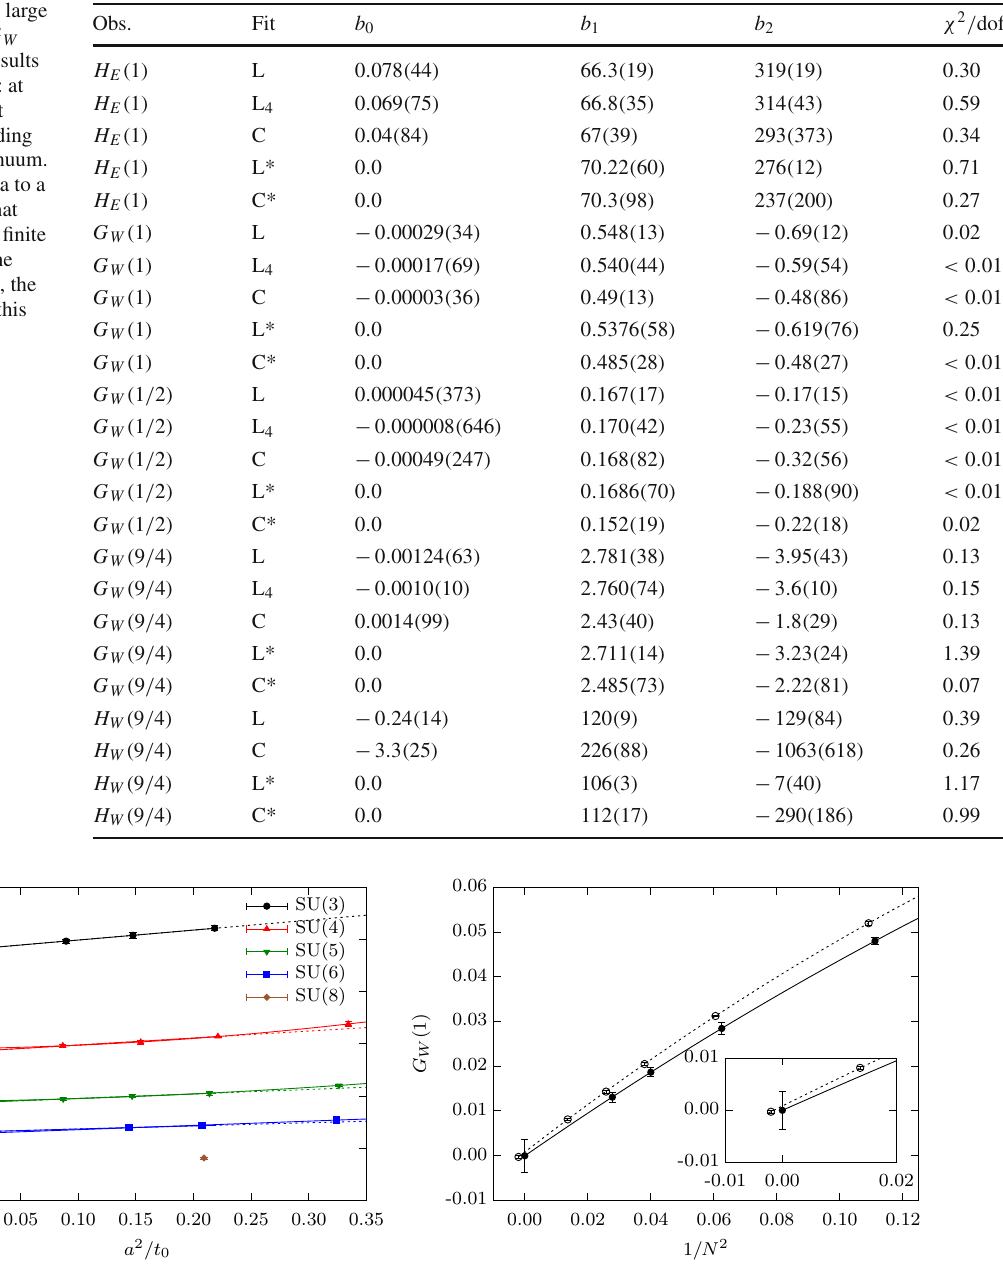
Fig. 7 Left: Continuum extrapolation of G W ( 1 ) for all gauge groups. Right: Large N extrapolations of G W ( 1 ) in the continuum (solid line) and at finite lattice spacing (dotted line). The points at finite lattice spacing have been slightly shifted for better